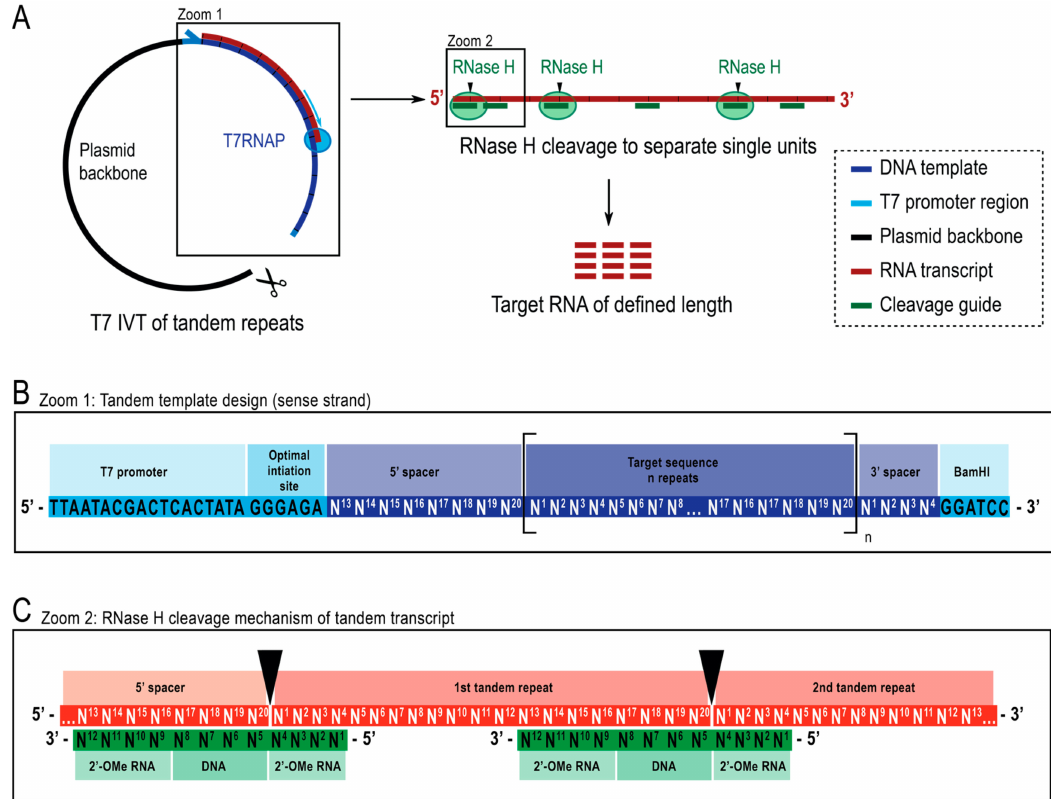
Figure 1. Schematic representation of the reported protocol. ( A ): (left) Tandem transcription from a linearized plasmid template with T7 RNA polymerase (T7RNAP) and (right) successive cleavage of the transcript to target length RNA by RNase H, directed by a chimeric DNA guide. ( B ): Detailed schematic of the tandem template, which starts with the viral T7RNAP promoter, an initiation sequence. The target sequence (dark blue, example here is 20 nt length) is repeated n number of times. The repeats flanked by a 5 (cid:48) - and 3 (cid:48) -spacer sequences consisting of the last eight and first four nucleotides respectively to allow for removal of the initiation and restriction sequences from the first and last repeat unit. ( C ): Hybridization of the tandem transcript (red) and the chimeric cleavage guides (green). RNase H cleaves the RNA opposite the DNA 5 (cid:48) -end. The 2 (cid:48) -OMe RNA flanks increase specificity by enhancing the binding a ffi nity of cleavage guide to the target